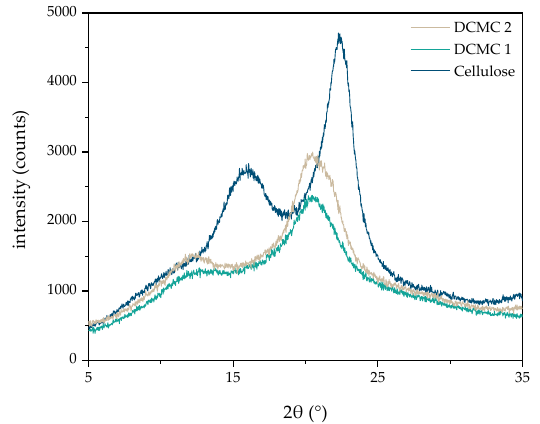
Figure 3. XRD pattern of cellulose and dicarboxymethyl cellulose sodium